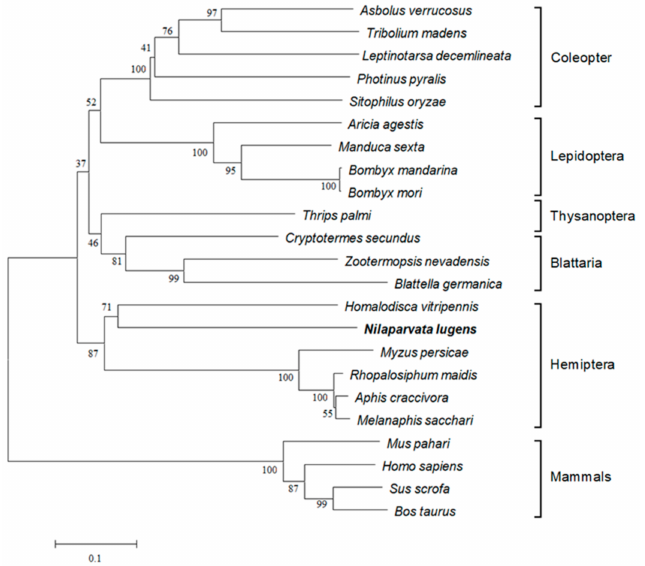
Figure 2. A phylogenetic analysis of ITIH4 based on amino acid sequence. Sequences were